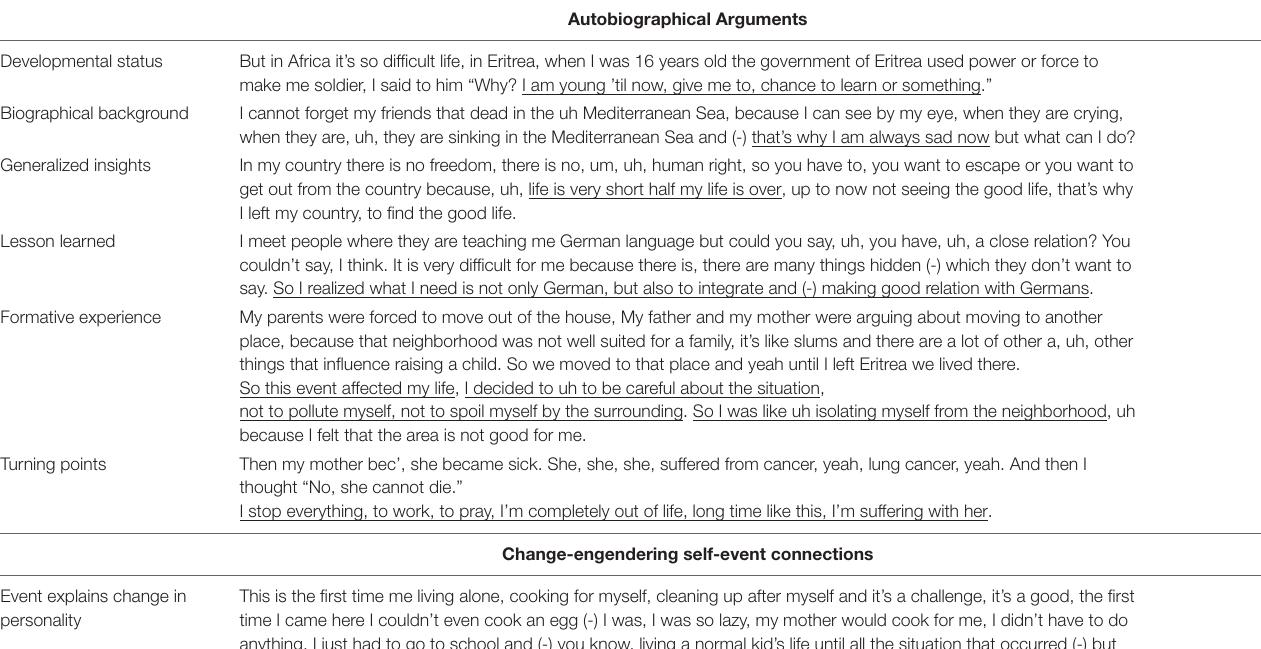
TABLE 1 | Excerpts of refugees’ life narratives with coding of autobiographical reasoning and self-event connections.